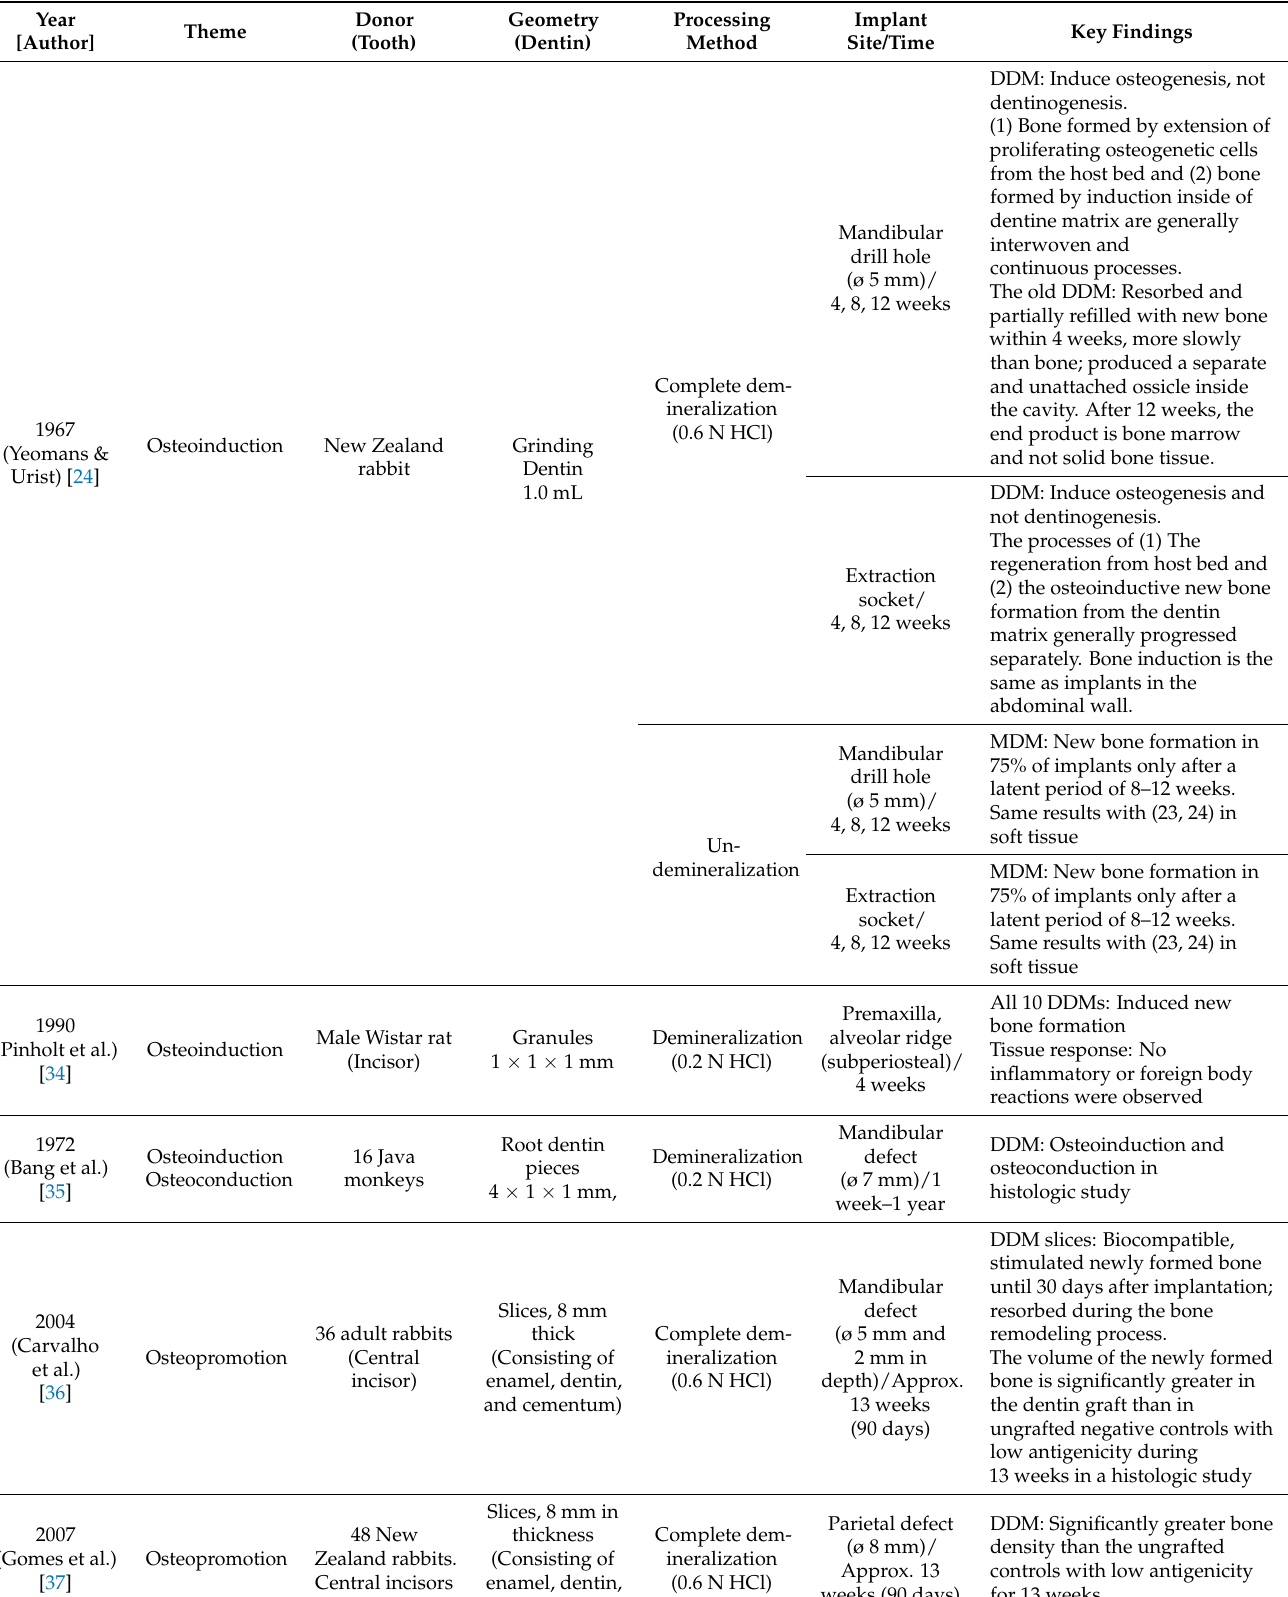
Table 2. Summary of preclinical evidence on the bone-forming capacity of allogeneic dentin at the skeletal